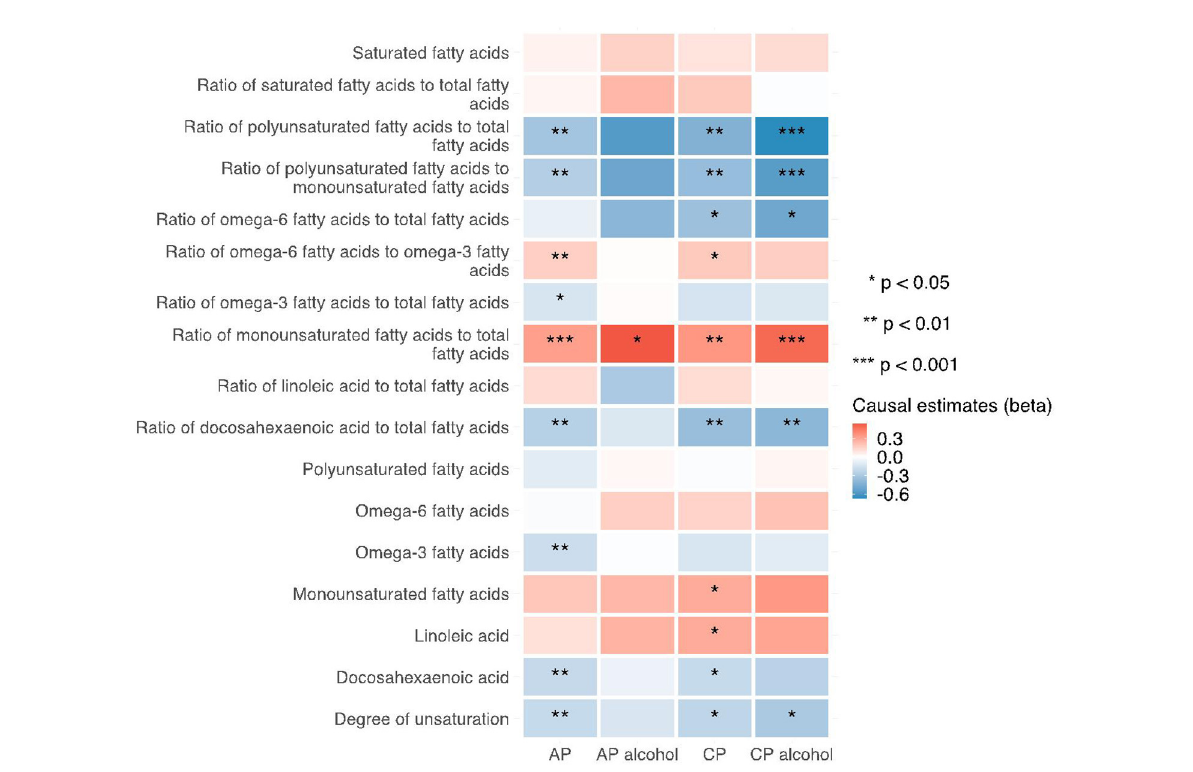
FIGURE5 Heatmap showing the IVW causal estimates of traits related with fatty acid (un)saturation in met-d on pancreatitis using two-sample MR. AP, acute pancreatitis; CP, chronic pancreatitis; IVW, inverse-variance